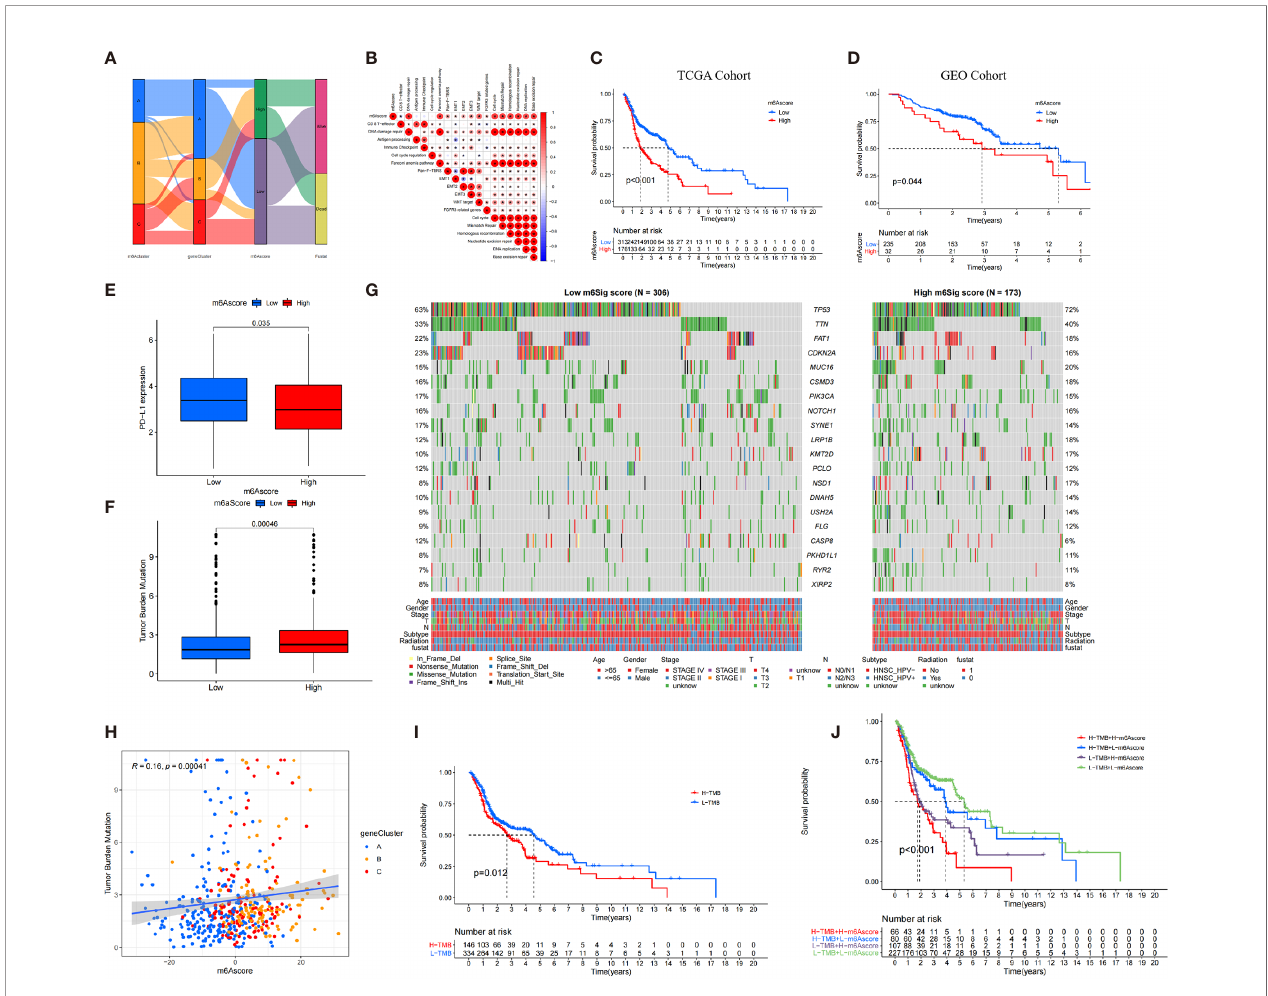
FIGURE 5 | The construction of m6A score and explore its relevant genetic features. (A) Alluvial diagram of m6A clusters in groups with m6A geneCluster, m6A score, and survival status. (B) Correlations between m6A score and the known biological gene signatures using Spearman analysis. (C, D) The survival analysis of patients in high and low m6A score subgroups in the TCGA cohort (C) and GEO cohort (D) . (E) Comparison of PD-L1 expression level in high versus low m6A score subgroups. (F) The distribution of tumor mutation load (TMB) in high versus low m6A score subgroups. (G) The waterfall of mutational landscape in TCGA strati fi ed by low (left panel) and high m6Sig score (right panel) subgroups. Each column represented one patient. Age, Gender, Survival status, HPV subtypes, Radiation, Stage were shown as patient annotations. (H) There was a signi fi cant positive correlation between the m6A score and TMB (R = 0.16, p < 0.001). (I) Kaplan-Meier curves for patients in high and low TMB subgroups. H, high; L, Low (P=0.012). (J) Kaplan-Meier curves for patient in the TCGA cohort strati fi ed by both m6A score and TMB. H, high; L, Low; TMB, tumor mutation load (P <